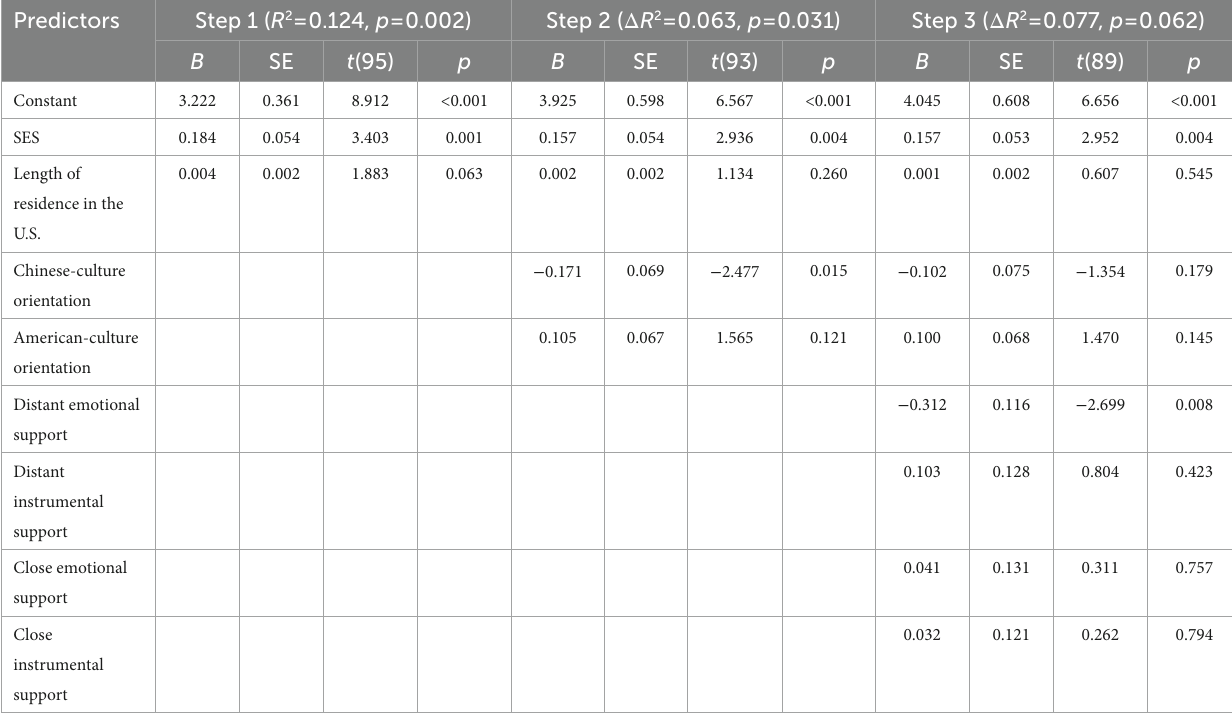
TABLE 6 Results of hierarchical regression analysis predicting psychological adaptation in the U.S. Predictors